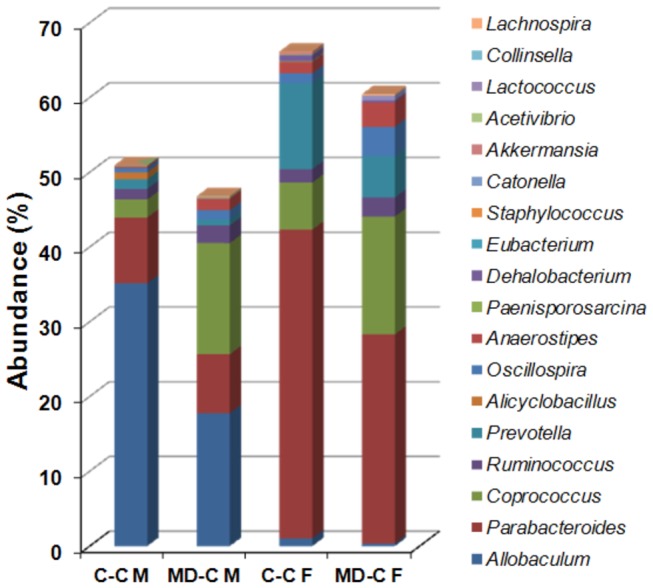
Genera level separation of colonic mucosal and fecal microbiomes upon prenatal MD supplementation.Combined representation of the 10-10 most prominently (by T test p value) differing genera in the mucosal and fecal (cecal content) samples, respectively, secondary to prenatal MD supplementation. Anaerosptipes and
Akkermansia
 overlapped between the mucosal and fecal comparisons. Hence 18 genera are depicted. Sixteen (90%) out of the 18 genera changed similarly in abundance between mucosa (M) and feces (F) upon prenatal MD supplementation at P90. Prenatally MD supplemented (MD-C) and control cross fostered groups (C–C) are compared. N=5.